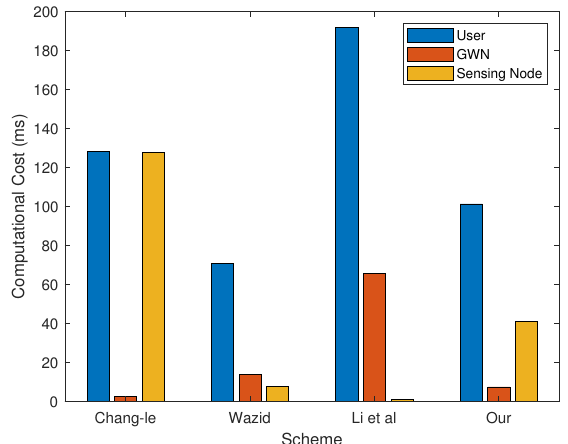
Figure 4. Computational overhead.